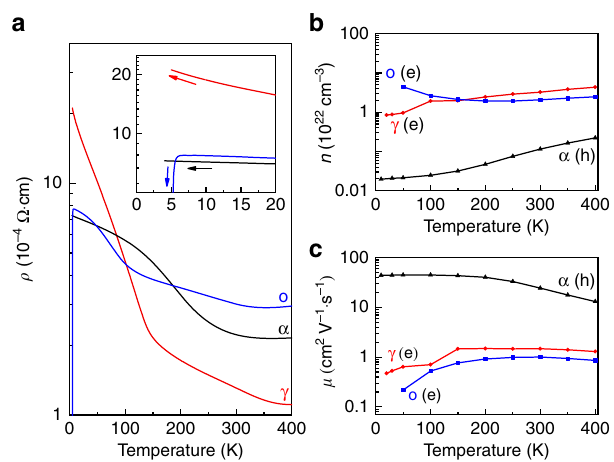
Fig. 5 Electronic transport properties of Ti 2 O 3 polymorphs. a Resistivity, b carrier concentration, and c carrier mobility of α -, o-, and γ -Ti 2 O 3 polymorphs. The inset in ( a ) shows the resistivity at temperatures below 20 K. Source data are provided as a Source Data fi